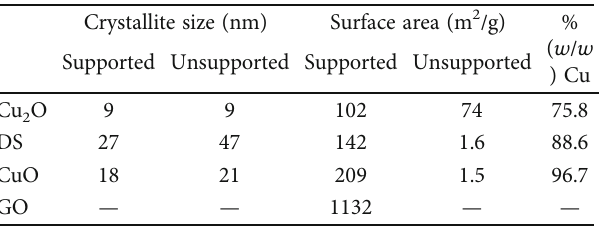
Figure 1: Experimental setup for photodegradation of RhB. Table 1: Calculated average crystallite size (Scherrer), surface area, and % ( w / w ) of Cu compound in the catalyst of supported and nonsupported nanoparticles in